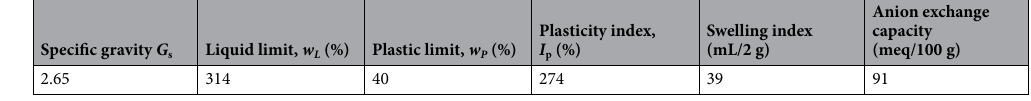
Table 2. Physical properties of the sodium bentonite.